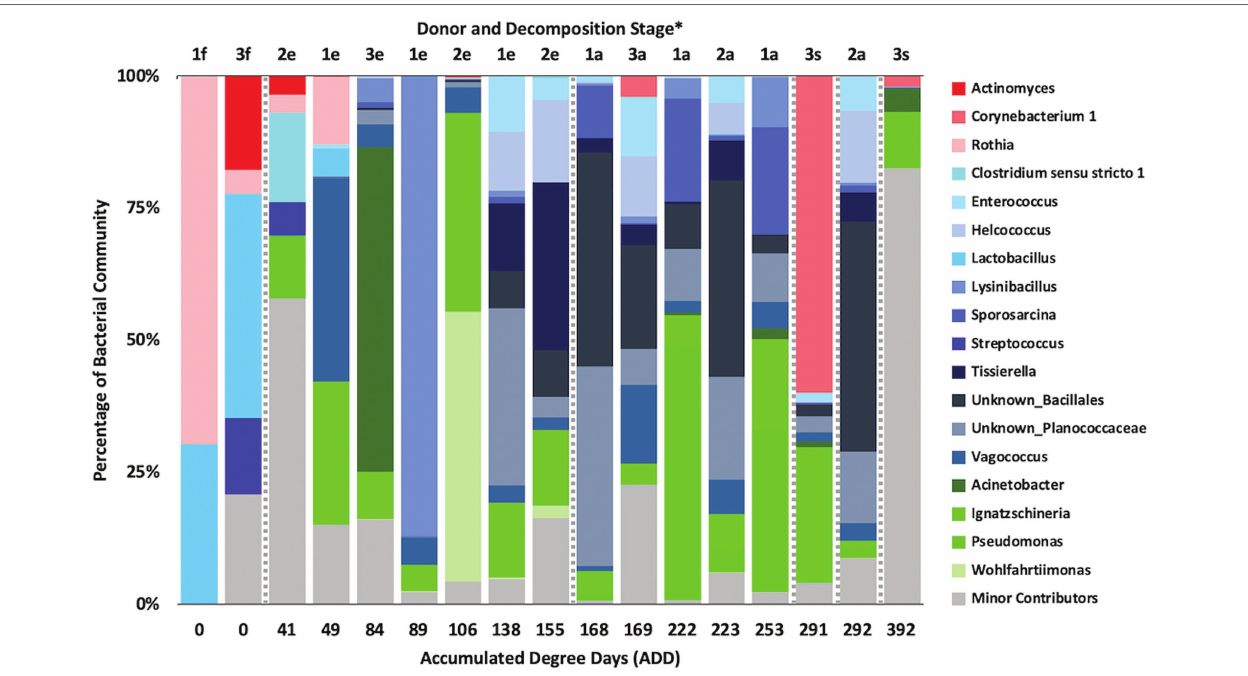
FIGURE 4 | Proportions of bacterial genera determined from 16S rRNA gene sequencing of the V6–V8 hypervariable region from oral samples of three human donors (Donors 1, 2, and 3) during decomposition. Decomposition was assessed as ADD on the x -axis and samples were also classified to an overall decomposition stage for each donor at each sampling event (* f , fresh; e , early; a , advanced; and s , skeletonized). Minor contributors include data that accounted for <1% of the total diversity within a